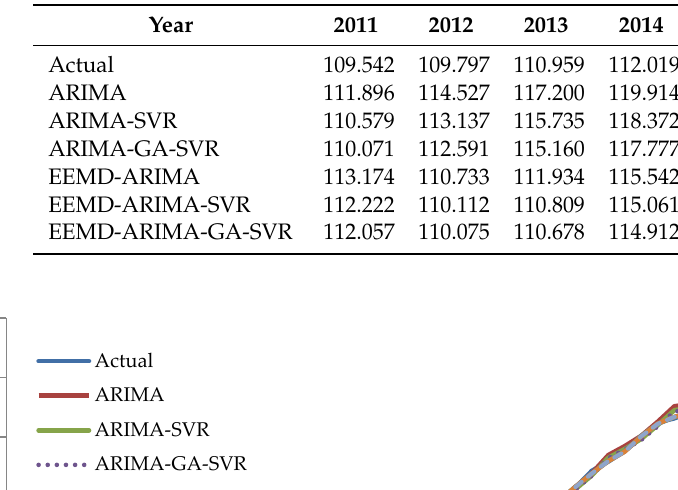
Table 3. Data Test by four sample ranging from 2011 to 2014.